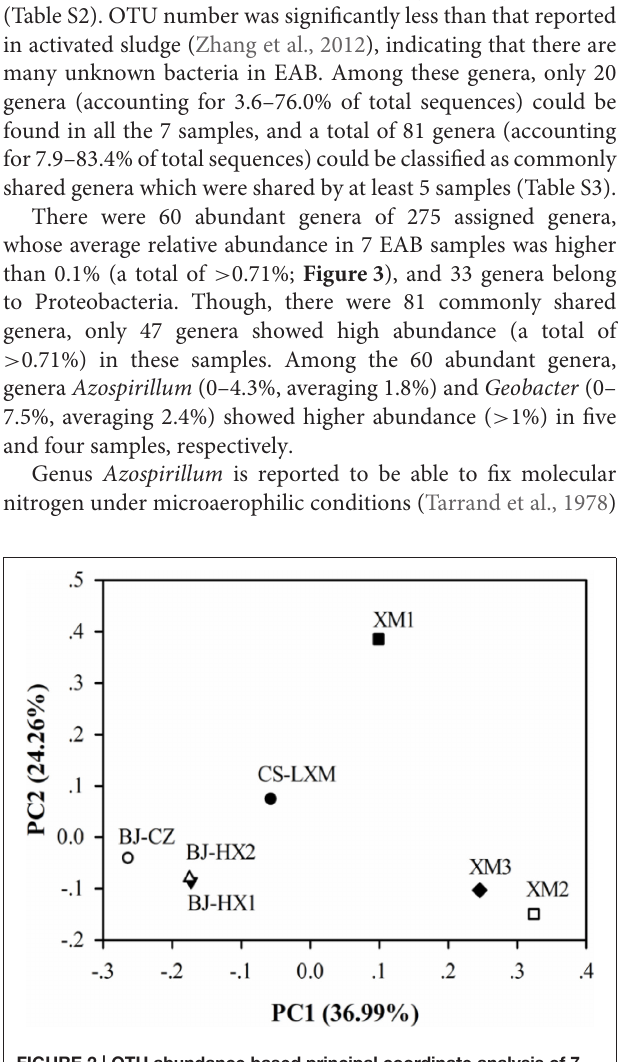
FIGURE 2 | OTU abundance based principal coordinate analysis of 7 EAB samples using weighted